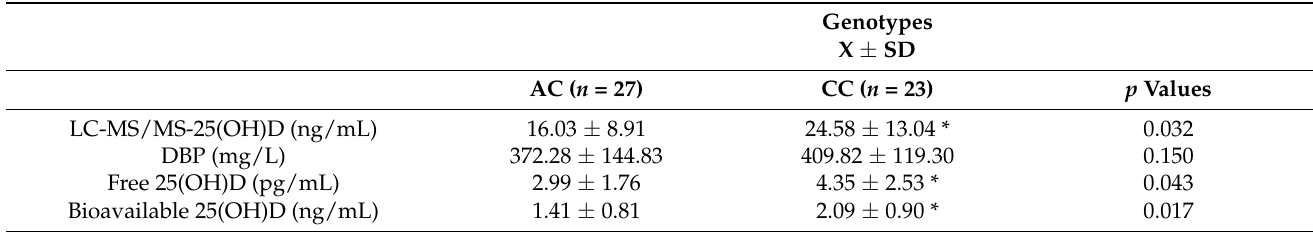
Table 3. Comparison of vitamin D parameters within two genotype cohorts of individuals with the rs4588 polymorphism.